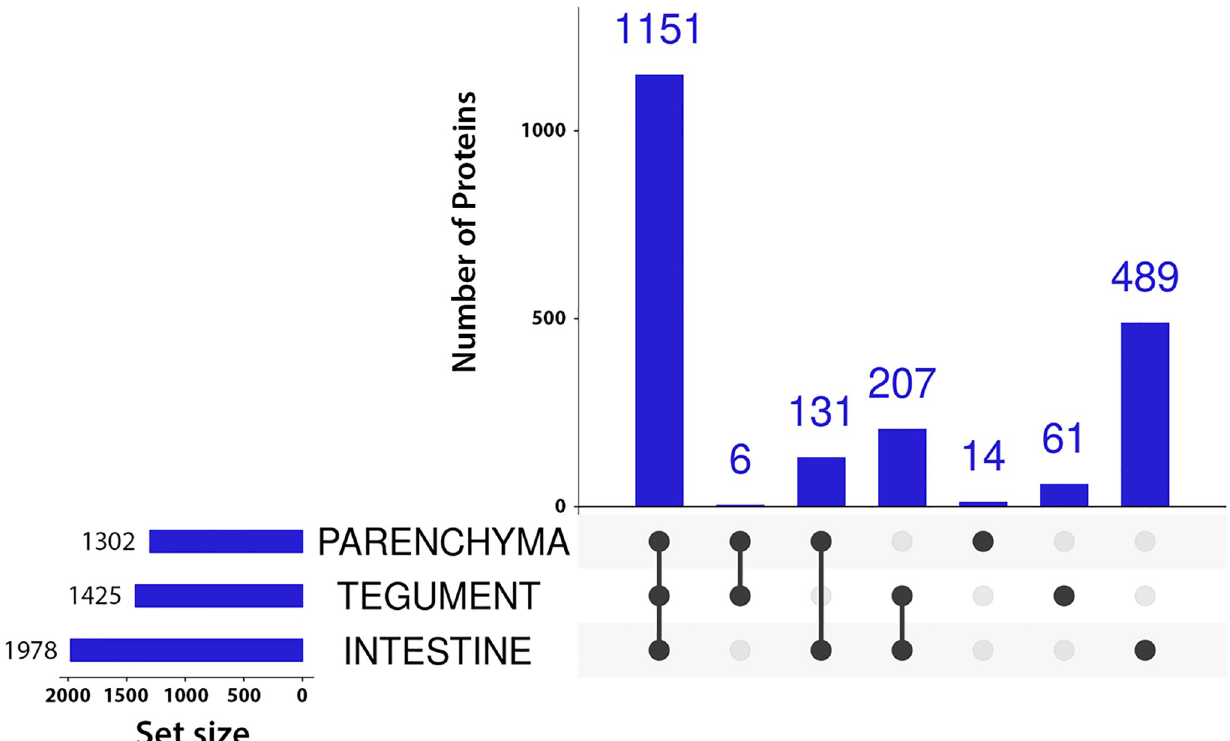
Fig 2. UpSet plot showing numbers of identifications in each tissue. Only proteins identified by � 2 peptides in at least one replicate are considered to be present. Intersections show proteins present in all tissues marked by connected black dots. Black dots without connections refer to proteins unique to that